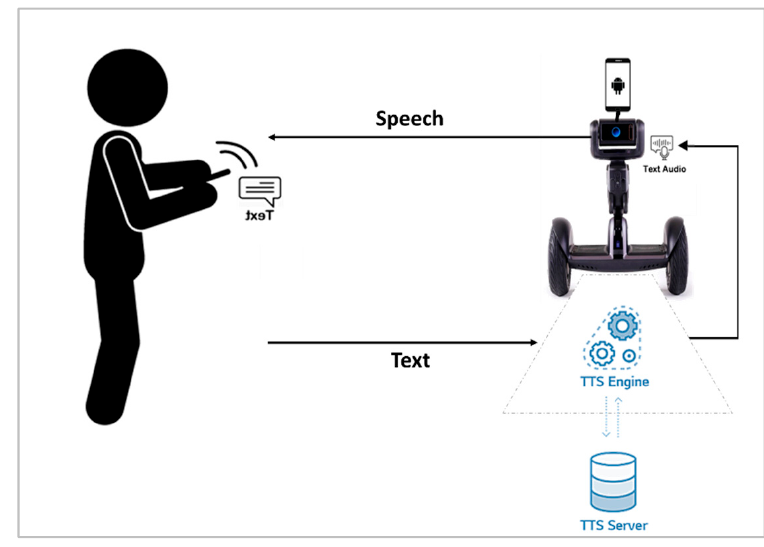
Figure 9. TTS communication in the communication layer.